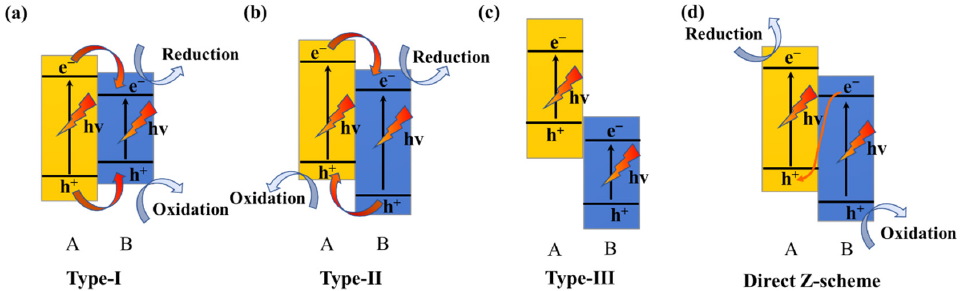
Figure 1. The charge-carrier separation mechanism on the type-I heterojunction ( a ), type-II hetero- junction ( b ), type-III heterojunction ( c ), and the direct Z-scheme ( d ), and heterojunctions built on two different semiconductors.